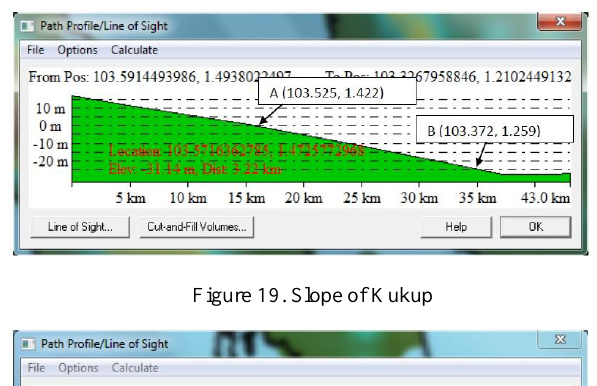
Figure 18. Slope of Sedili